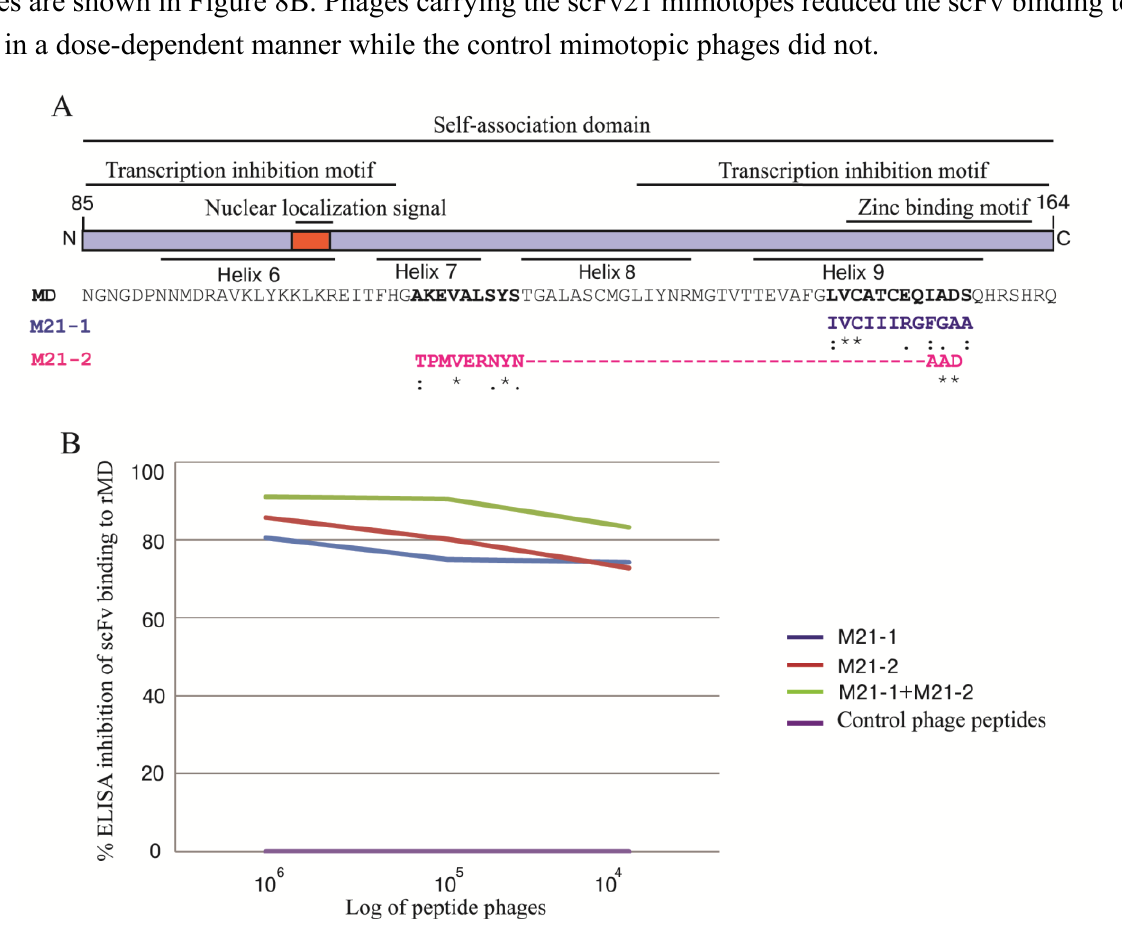
Figure 8. Alignment of the phage mimotopic peptides with the linear sequence of the influenza A virus M1 MD for determining the tentative MD residues bound by the scFv21 and the results of the ELISA inhibition for verification of the phage mimotopes. ( A ) The phage mimotopic peptides, M21-1 and M21-2, matched with residues 146LVCATCEQIADS157 and 112AKEVALSYS120 and 154IAD156 of the M1 MD sequence, respectively; ( B ) ELISA inhibition indicated that the M21-1 and M21-2 phage mimotopes and their mixture blocked the scFv21 binding to the rMD protein which validated the scFv epitope predicted by